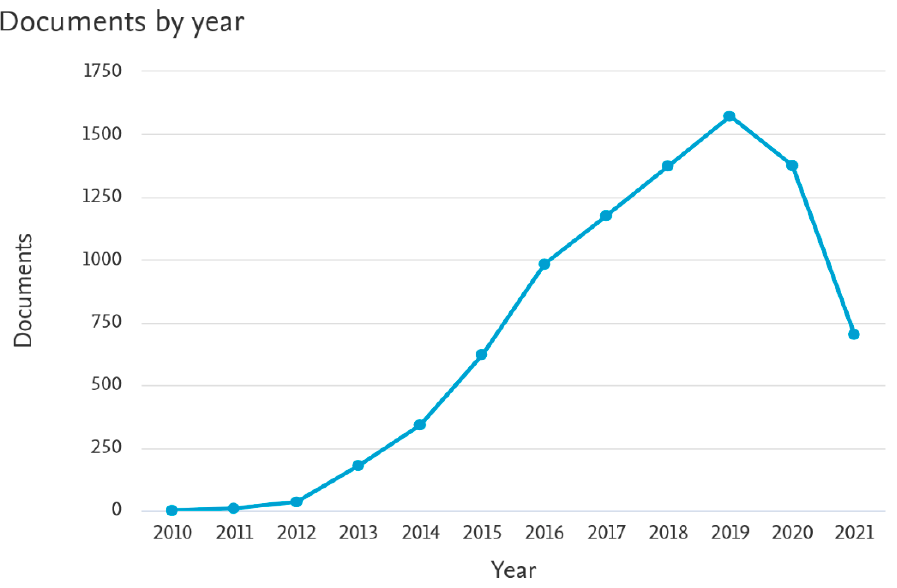
Figure 5. Documents found in Scopus for the “big data analytics” key phrase by year of publication.